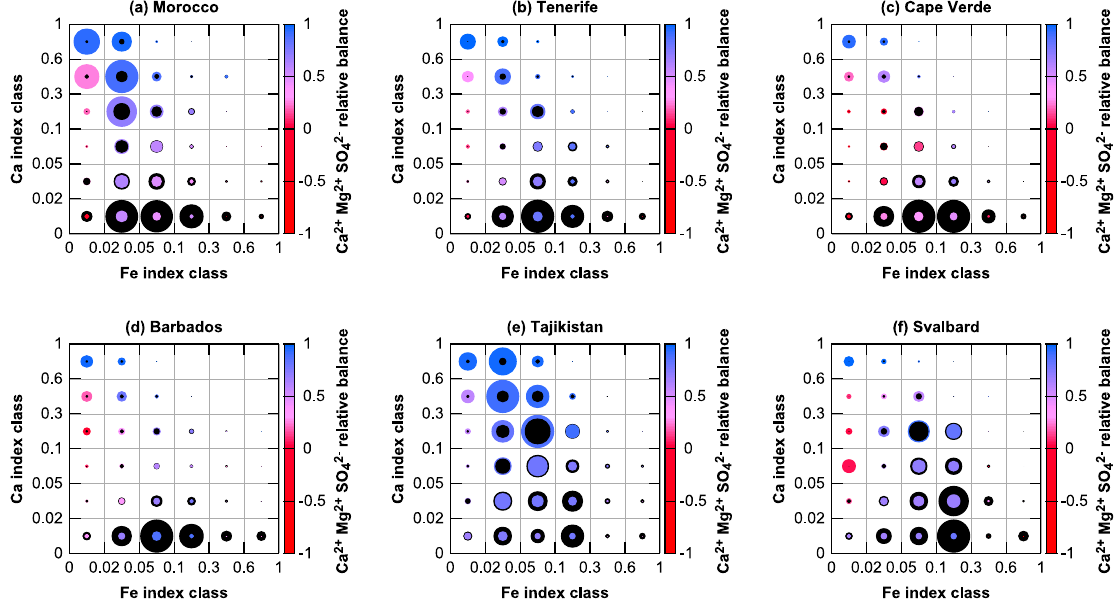
Figure 6. Mixing state of iron (black circles) and calcium (colored circles) as functions of Ca and Fe indices for near-source ( a , e , f ) and transported ( b – d ) dust dry deposition. The circle area is proportional to total iron or calcium mass found in each class, normalized to the highest mass for each sampling location. The blue-red transition shows the average relative ion balance of Ca 2+ + Mg 2+ versus SO4 2 − , indicating atmospheric processing.